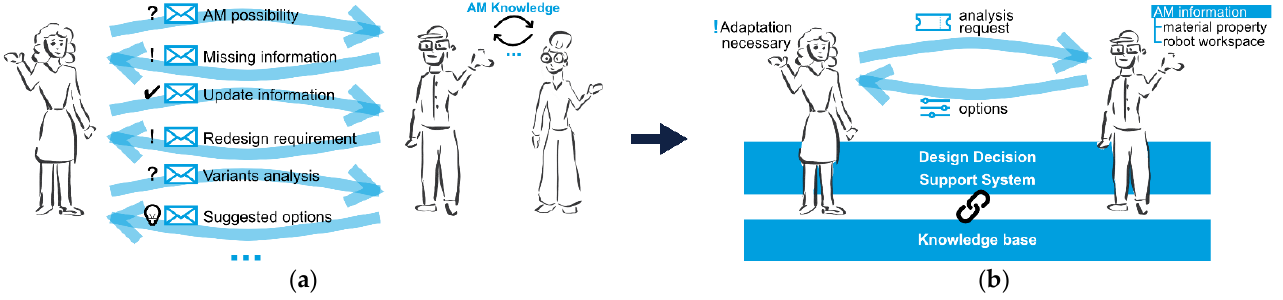
Figure 2. ( a ) Conventional design routine with considerable iterations applied to AM construction. ( b ) Proposed methodology enabling efficient design decision-making of AM methods through the knowledge base and communication